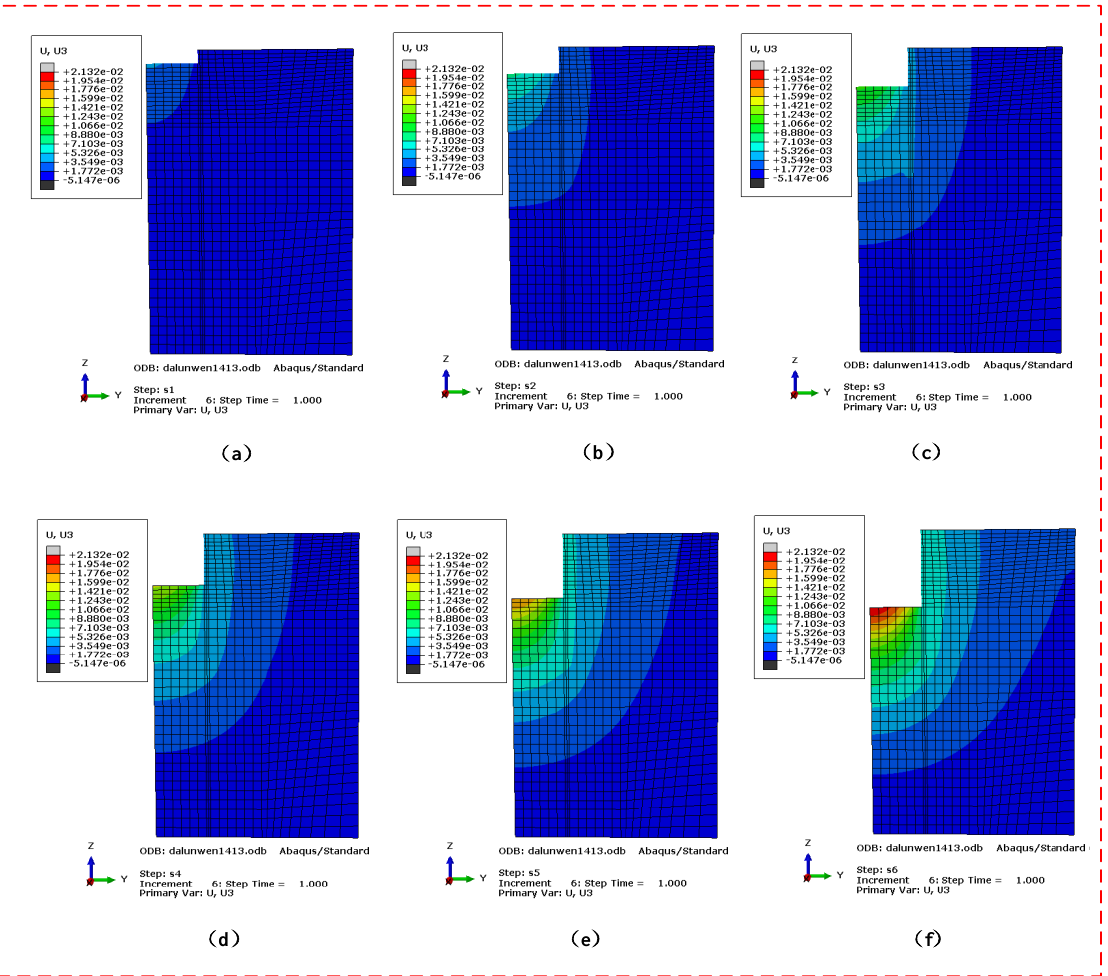
Figure 10. Vertical displacement cloud image of soil: ( a ) underground first floor; ( b ) underground second floor; ( c ) underground third floor; ( d ) underground fourth floor; ( e ) underground fifth floor; ( f ) underground sixth floor.